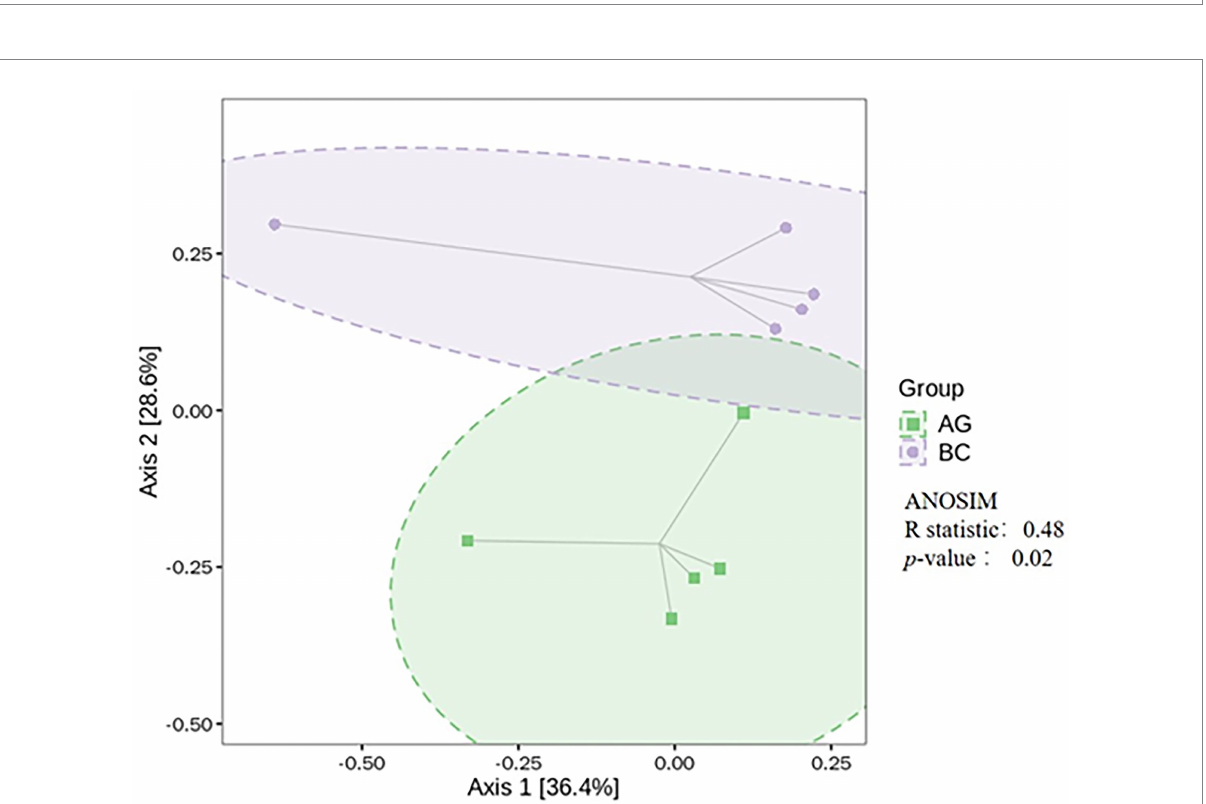
FIGURE 3 Comparison of β -diversity in the gut microbiota between Xinjiang brown cattle (BC) and Angus cattle (AG). ( n = 5 in each breed). ANOSIM, analysis of